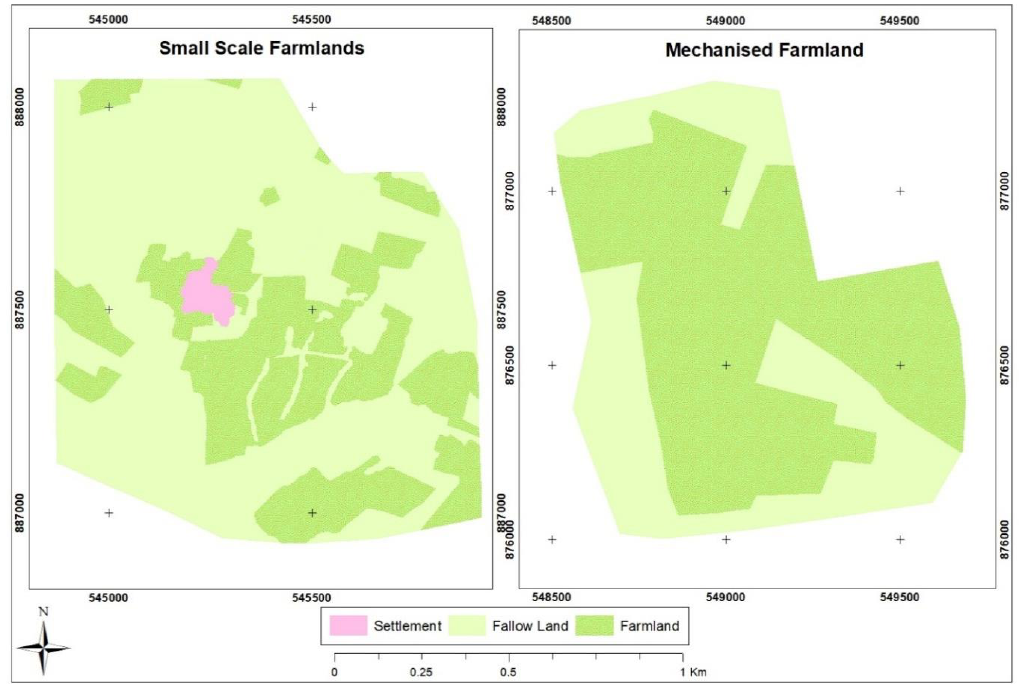
Figure 5. Crop fields digitised from the Figure 5 reveals that the small-scale farms are disjointed and fragmented, and this affects the level of productivity